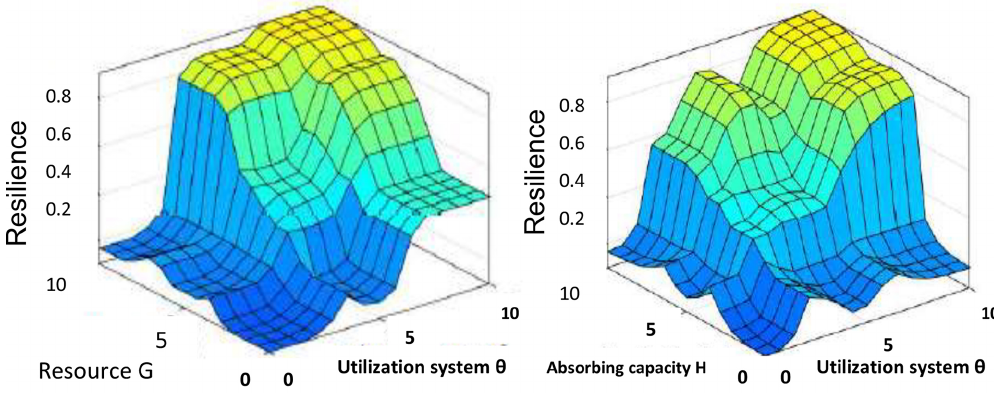
Figure 8. Examples of resilience output surface plots. Table 4. Linguistic variables input template (to be used with Table 1 as a scoring guide). Linguistic